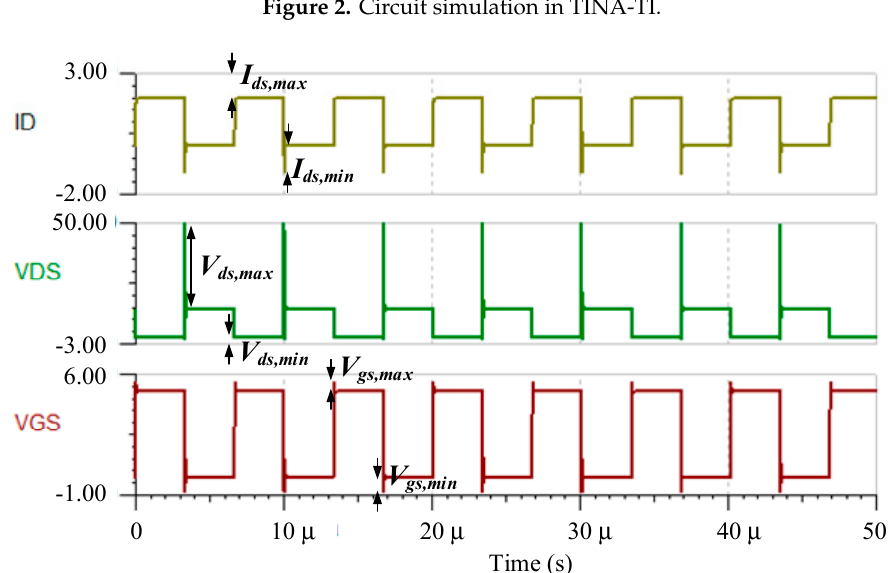
Figure 2. Circuit simulation in TINA-TI.